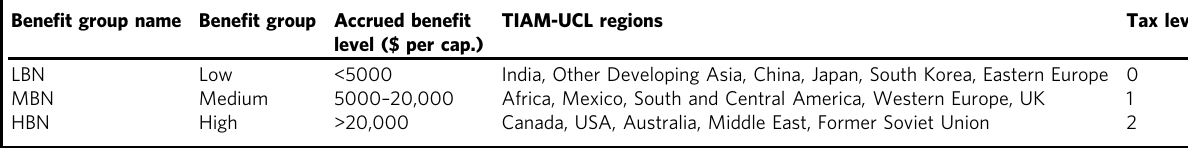
Table 2 Accrued bene fi ts criteria groups and their composition based on regions in TIAM-UCL.